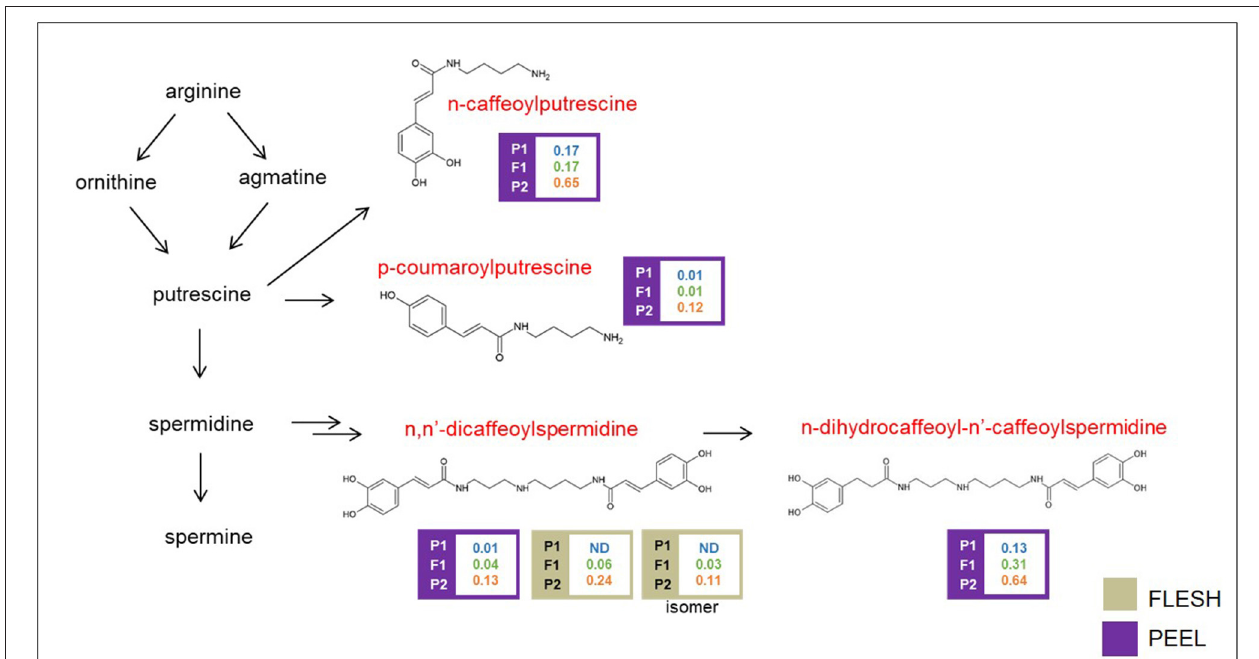
FIGURE 5 | Biosynthetic pathway of polyamine conjugates. Levels of detectable metabolites are expressed as fold/ISTD (Internal Standard: formononetin) in parental lines “67/3” (male) and “305E40” (female) and the F1 progeny. Metabolites marked in red were identified by the untargeted analysis.